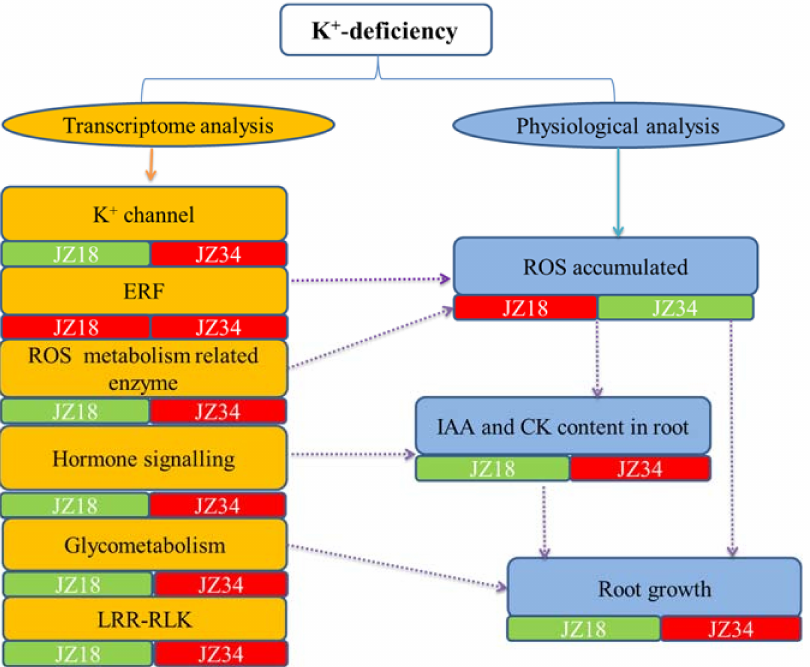
Figure 9. A hypothetical model of the response to K + -deficiency stress in two tomato genotypes. The green box represents downregulated DEGs, and the red box represents upregulated DEGs. The dotted lines represent potential